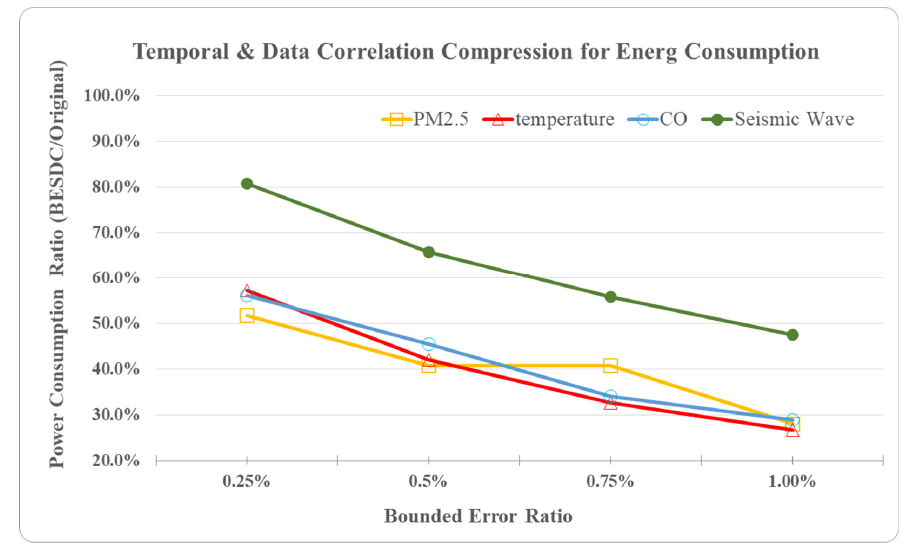
Figure 7. Energy consumption ratio in ED via BESDC.